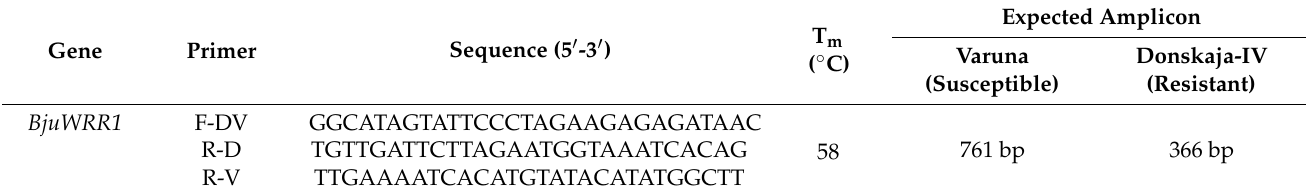
Table 2. Primer details used in the present